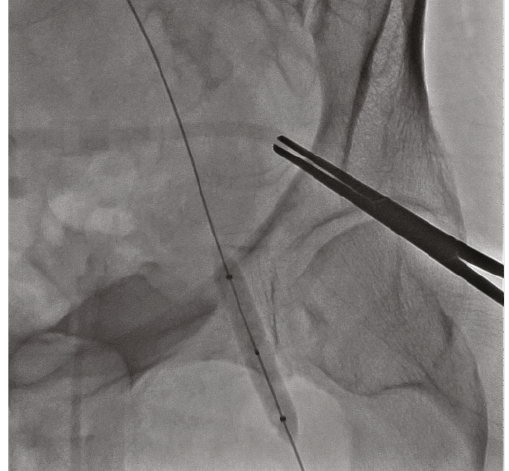
Figure 7: Left coronary angiogram at 6-month follow-up showing continued patency of the previously placed